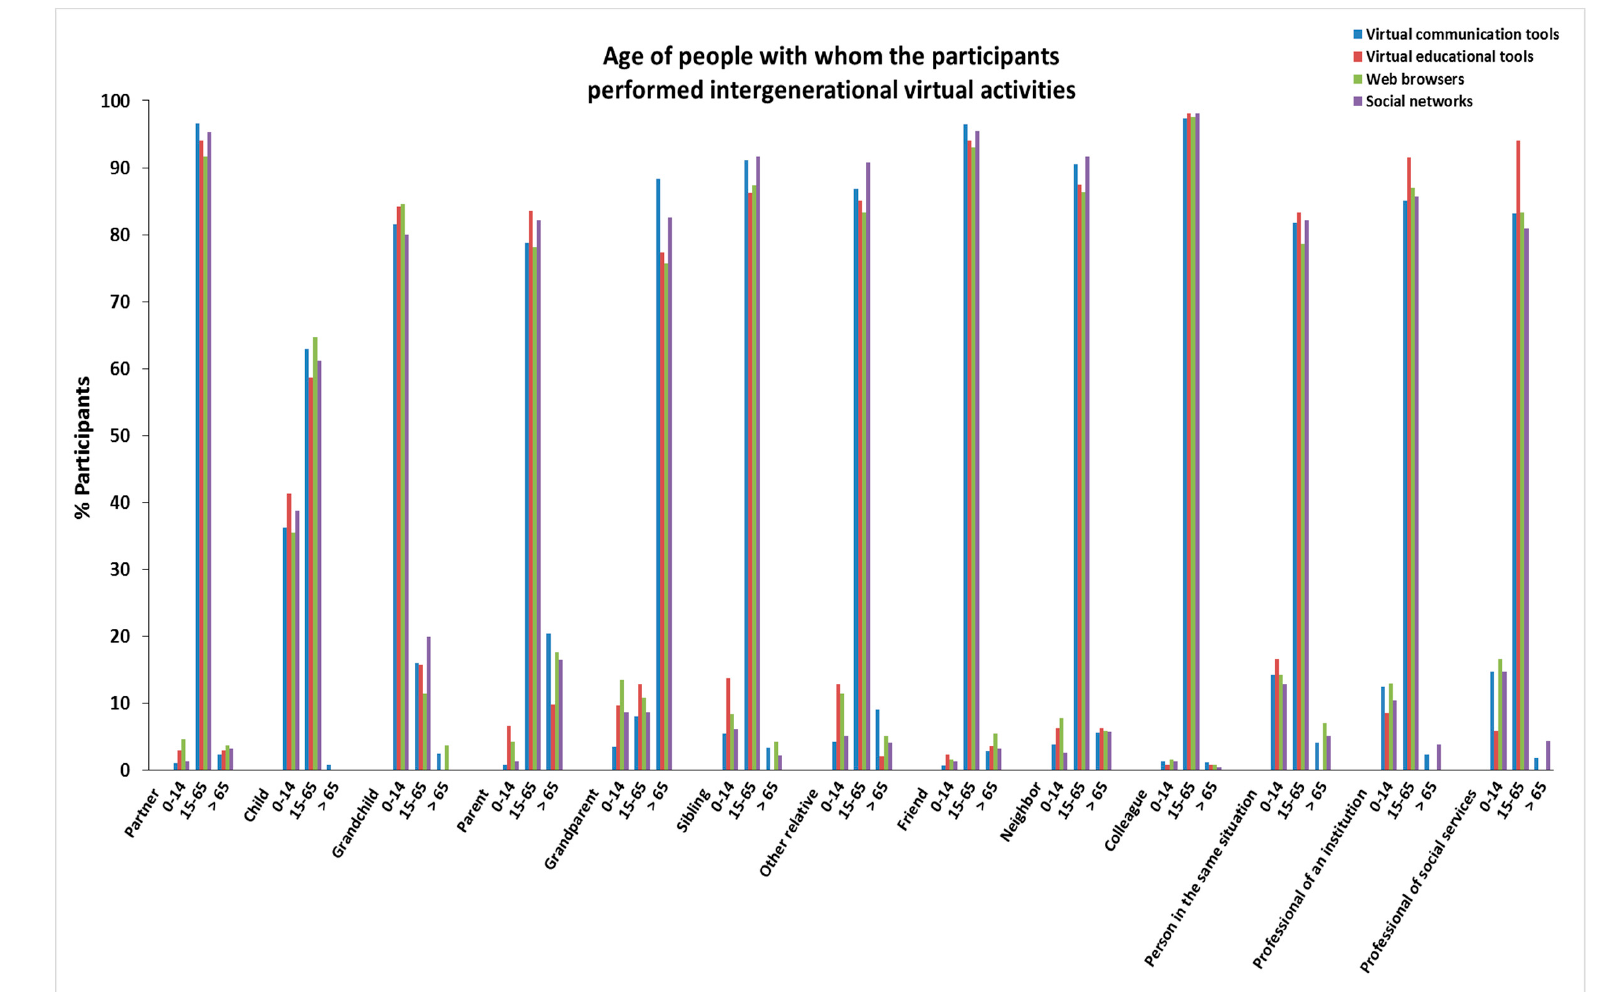
Figure 1. Age of people with whom the participants performed intergenerational virtual activities.